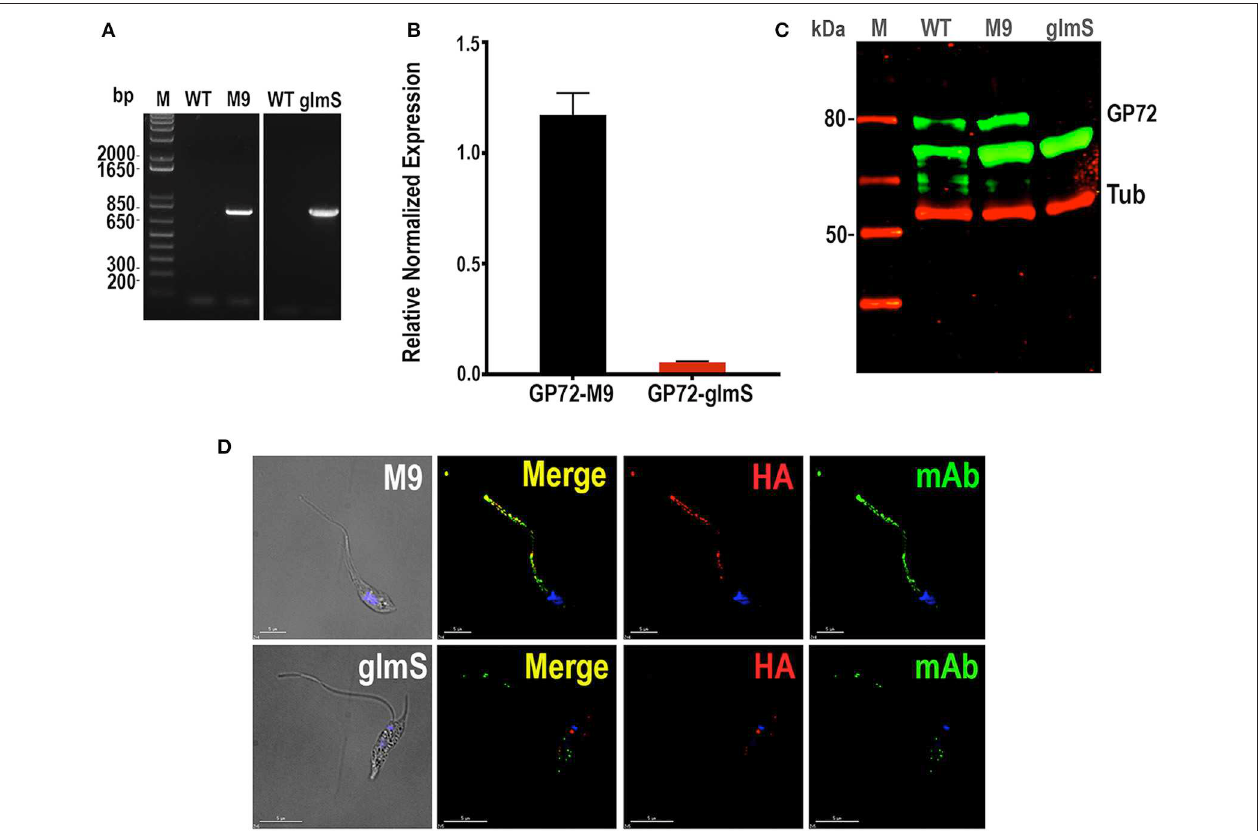
FIGURE 2 | Integration of glmS/M9 ribozyme sequences into the TcGP72 gene. (A) PCR analysis using gDNA isolated from WT and TcGP72-M9/glmS (M9, glmS) cell lines. A DNA fragment of 779 bp was amplified in 3xHA-glmS/M9 -tagged epimastigotes, whereas the band is absent in WT cells. (B) qRT-PCR shows down-regulation of TcGP72 . (C) Western-blot analysis of TcGP72- M9/glmS cell lines. Antibody WIC 29.26 labels a band of 72 kDa in TcGP72-3xHA - M9 - but not in TcGP72-3xHA - glmS -tranfected cells. Anti-tubulin antibody (Tub) was used as loading control. Antibodies are indicated on the right side of the blots, and molecular weights (kDa) are on the left side. (D) Immunofluorescence microscopy of TcGP72-3xHA-M9- and TcGP72-3xHA-glmS -transfected epimastigotes. There is co-localization in the flagellum of anti-HA and WIC 29.26 antibodies in TcGP72-3xHA-M9 -transfected epimastigotes ( merge ) while the flagellum is detached and has little labeling with anti-HA and reduced labeling with WIC 29.26 in TcGP72-3xHA-glmS -expressing cells. DIC, differential interference contrast microscopy. Scale bars = 5 µ